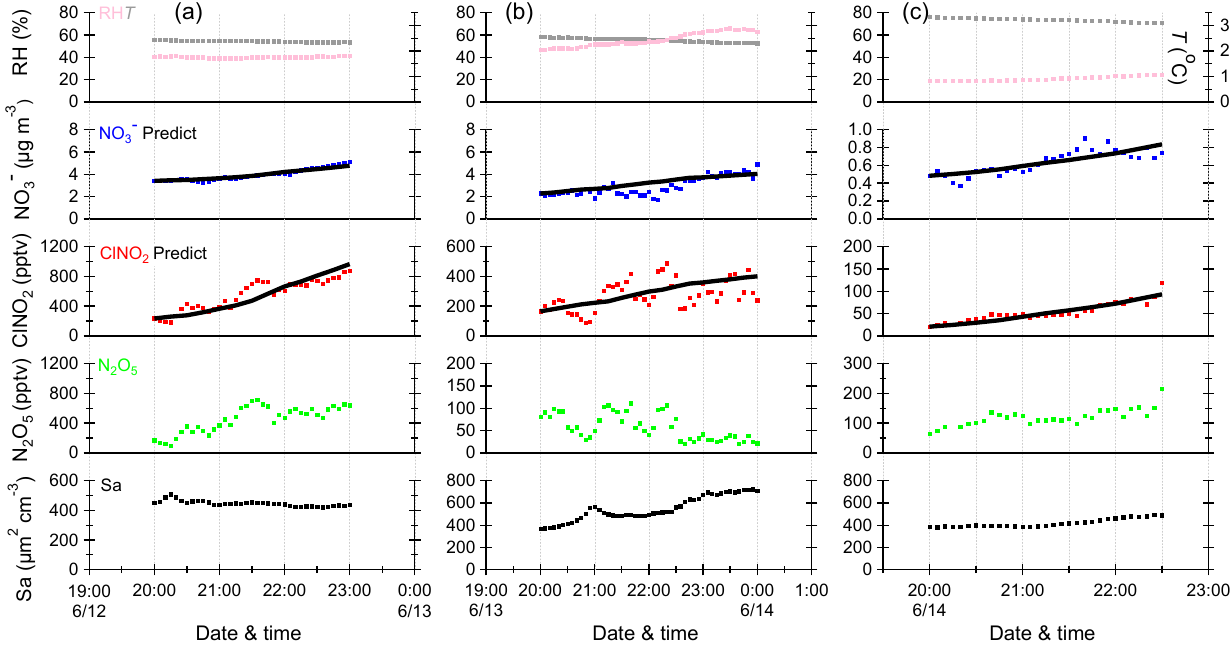
) , mixing ratios of N 2 O 5 and ClNO 2 , and aerosol 3 3